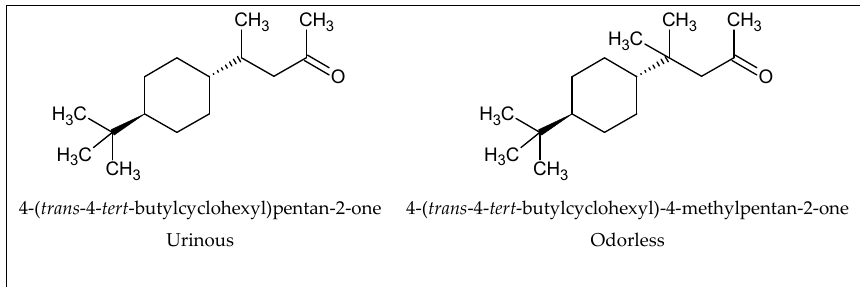
Figure 5. Example of the changing odorant character of a compound with slight structural modification.